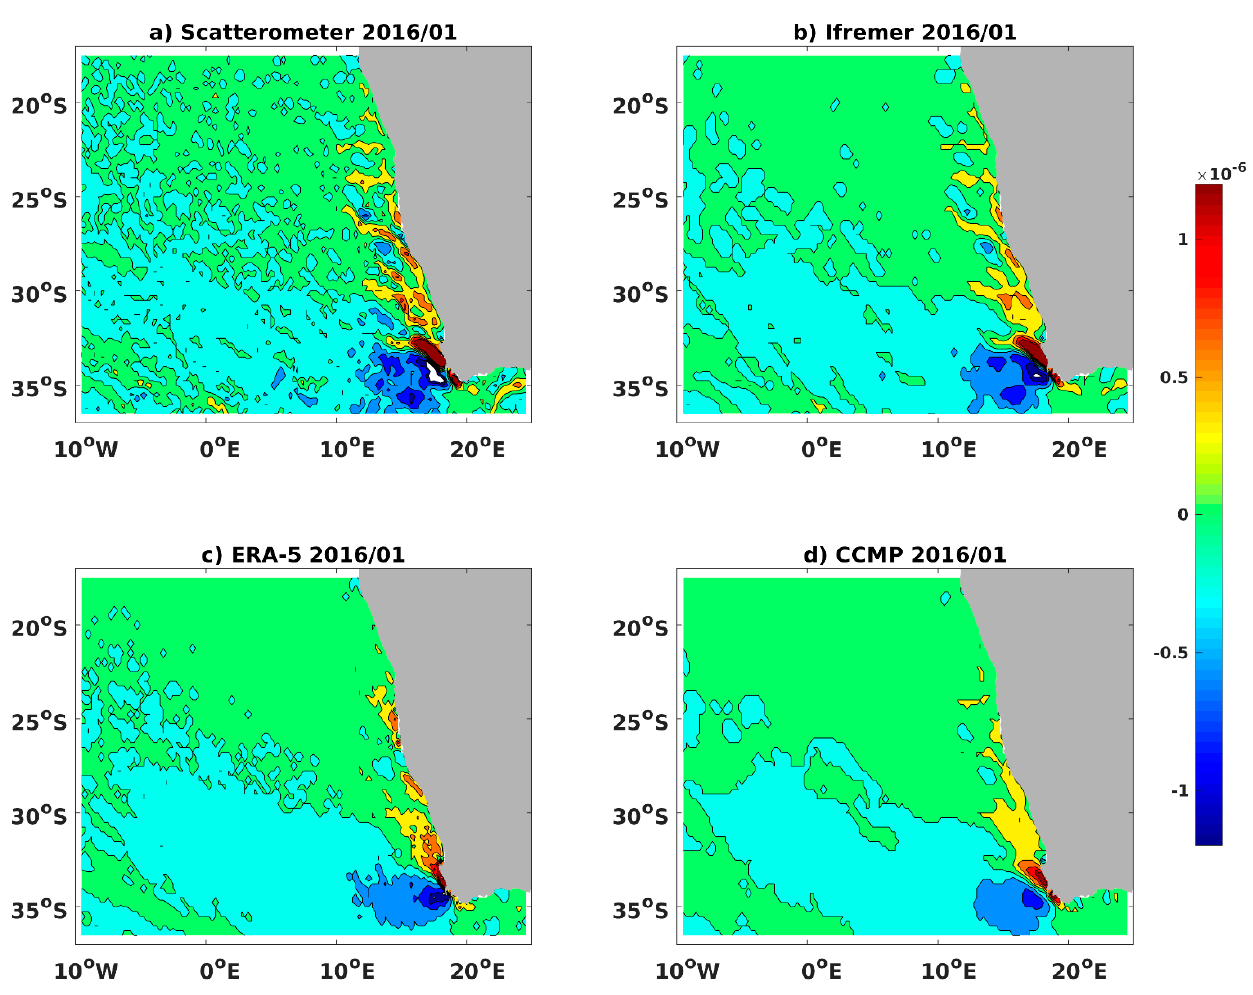
Figure A9. Monthly-averaged mean of wind stress curl estimated from collocated ( a ) scatterometer (ASCAT), ( b ) Ifremer, ( c ) ERA-5, and ( d ) CCMP wind data occurring in January 2016 over Benguela zone. Colors indicate curl amplitudes in N/m 3 . White and black colors indicate curl values lower than − 1.210 − 6 N/m 3 and higher than 1.210 − 6 N/m 3 , respectively.